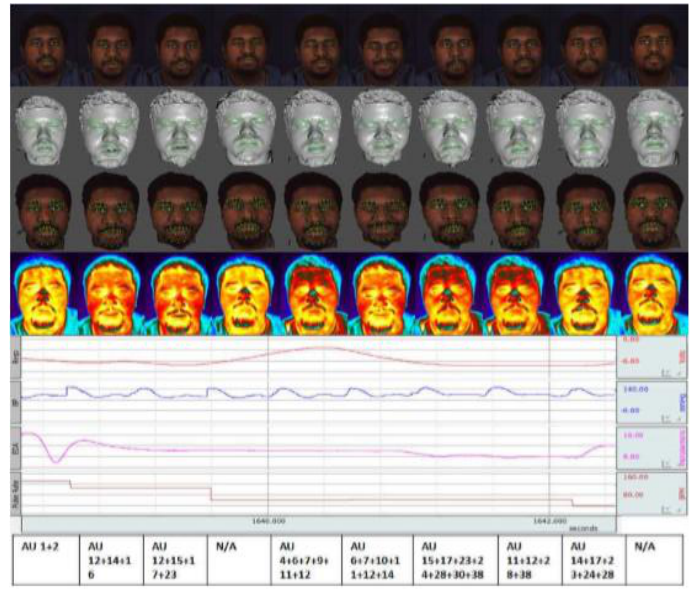
Figure 3. A sample from MMSE dataset which each row from top to bottom shows the 2D image of individual, shaded model, textured model, thermal image, physiological signals, and action units, respectively [116].